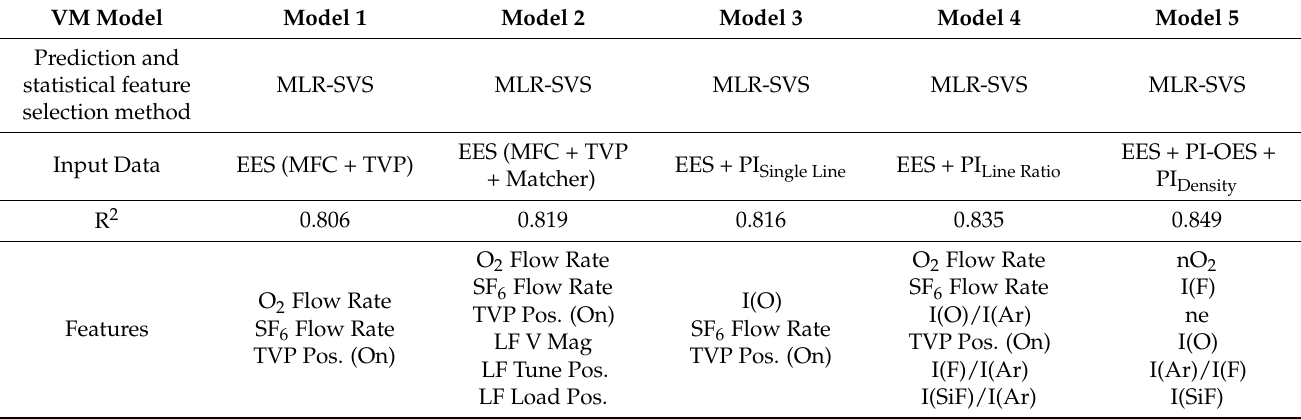
Table 3. R 2 and features of PI-VM (etch depth) by sequentially including EES, PI-OES, and PI Density in the input data set. VM